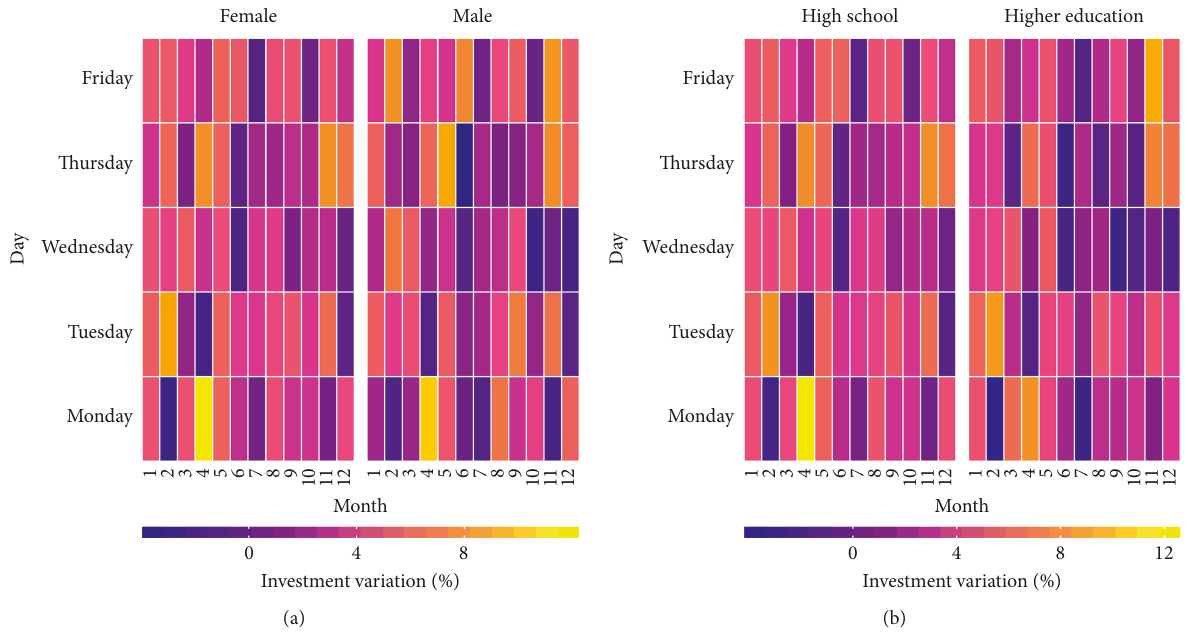
Figure 1: Heatmap showing average daily investment changes (%) in 2016 broken down by investor’s gender (a) and education degree (b). We take average values of investment decisions that took place in every weekday within the month. Due to the existence of some large absolute values and to improve readability, we winsorize the investment variation distribution by 5% at each side before taking the average.